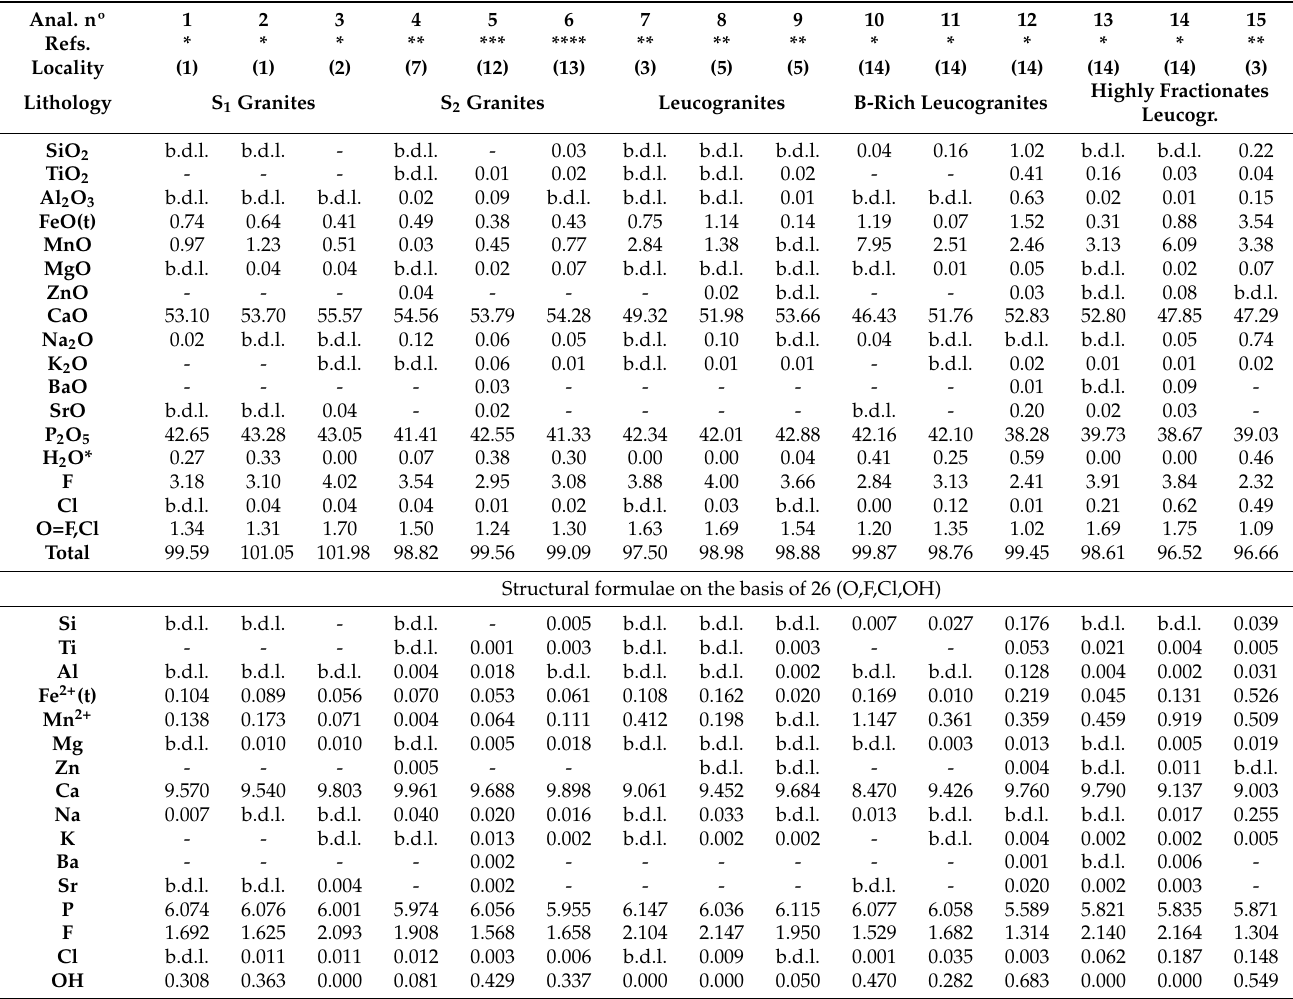
Table 2. Representative microprobe analyses with major element composition (wt.%) and unit formula (a.p.f.u.) calculated on the basis of 26 (O,F,Cl,OH), H 2 O* estimated, for apatite associated with the different granitic lithologies from the CIZ. Locality number as in Figure 1 and Table 1. References: * this work; ** Merino-Mart í nez [86]; *** Neiva et al., [88]; **** Errandonea-Mart í n [103]. b.d.l. below the detection limit.—not analyzed.